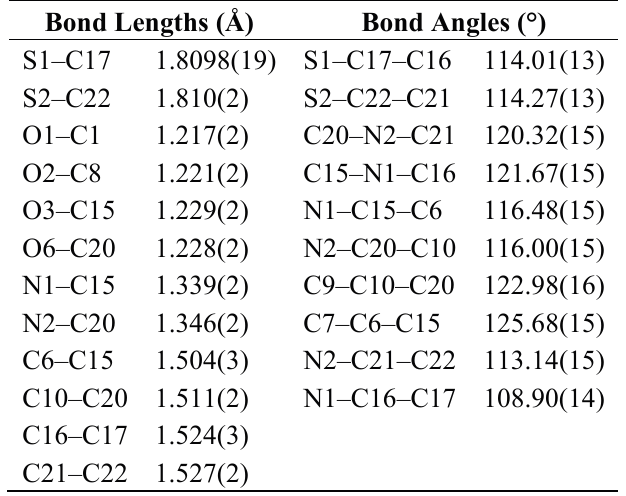
Table 1. Selected bond lengths (Å) and bond angles